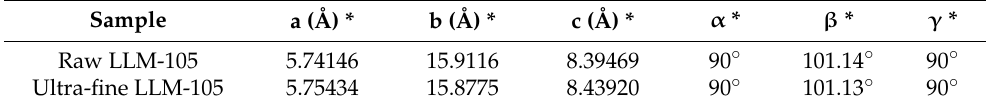
Table 1. The parameters of LLM-105 crystal structure model with different particle sizes.